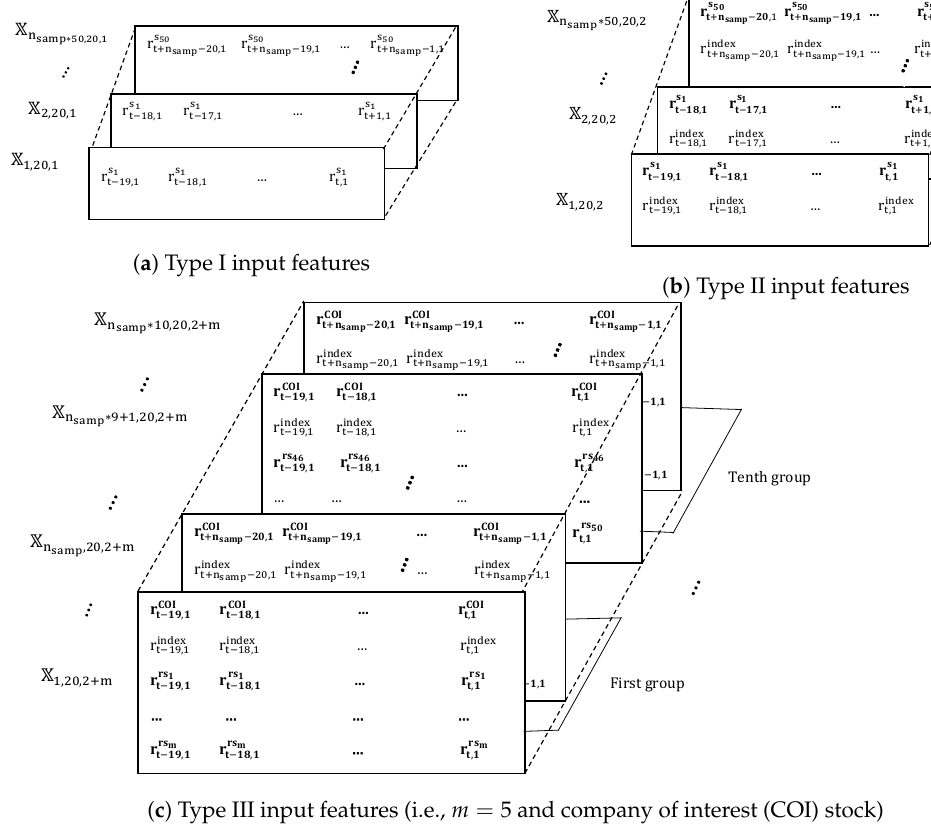
Figure 4. Training samples with different types of input